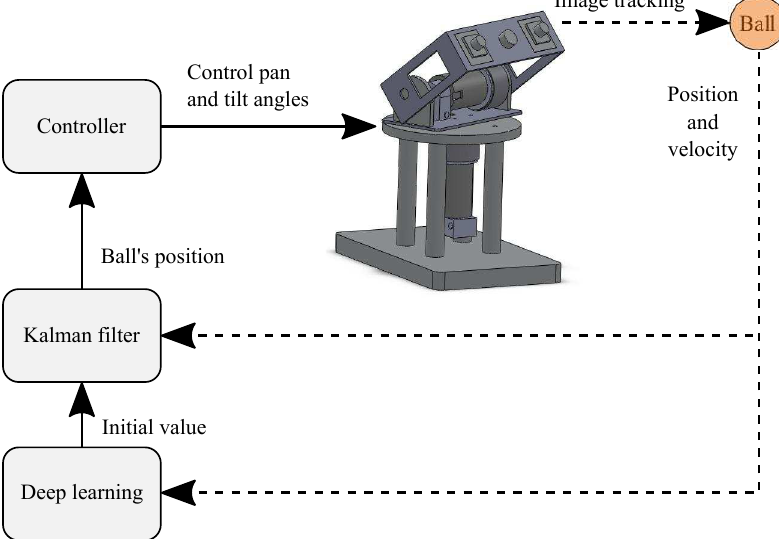
Figure 6. Kalman filter combined with deep learning.